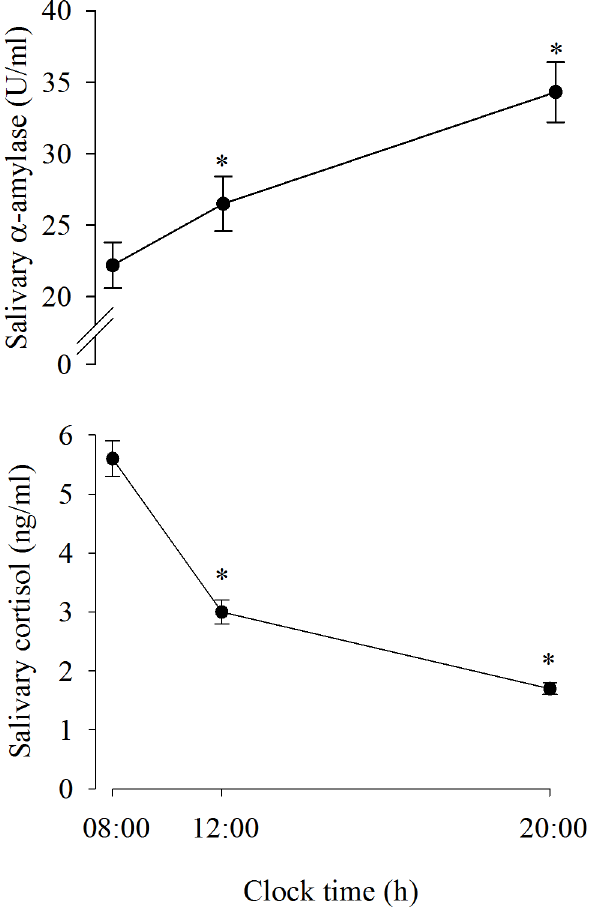
Fig 1. Diurnal trajectories of salivary α -amylase and salivary cortisol during a rest day. Data are expressed as the mean ± SE. (cid:3) : p < 0.001 vs 08:00.